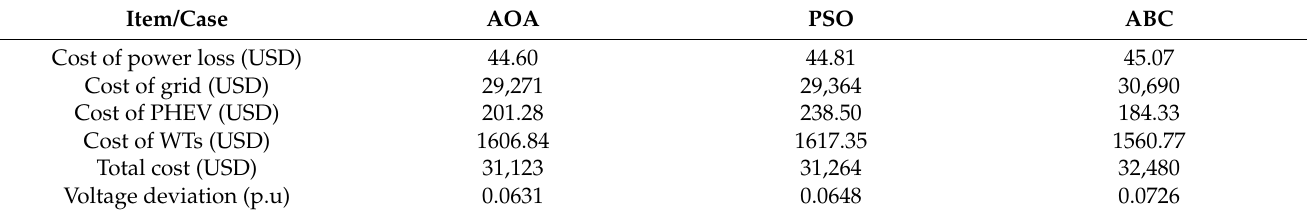
Table 7. Numerical results of PV and PHEV sizing and placement in the 33-bus distribution network.